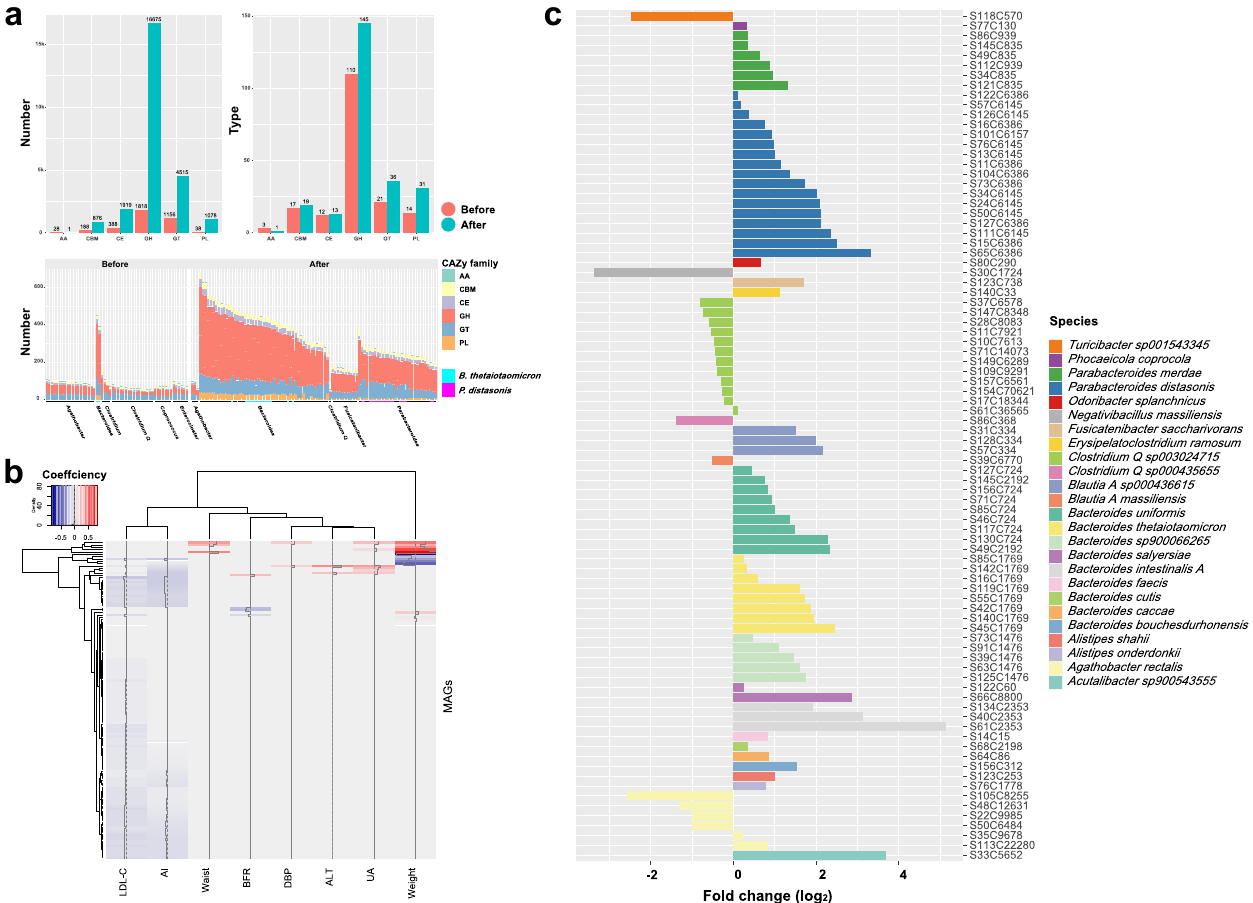
Fig. 3 Richness and diversity of carbohydrate-active enzymes in MAGs enriched before and after the intervention. a Comparison in counts of carbohydrate-active enzyme subfamilies and copy number of carbohydrate-active enzymes (CAZymes) encoding genes observed in the metagenome-assembled genomes (MAGs) enriched before and after the IF intervention. b Heatmap of associations between the relative abundances of MAGs and clinical parameters of participants. Red represents a positive correlation, whereas blue represents a negative correlation. AI atherosclerosis index; ALT alanine aminotransferase; BFR body fat ratio; DBP diastolic blood pressure; LDL-C low-density lipoprotein cholesterol; UA uric acid. c Enrichment of MAGs negatively correlated with AI. The MAGs with a fold change less than zero were enriched before the IF intervention, and those with values above zero were enriched